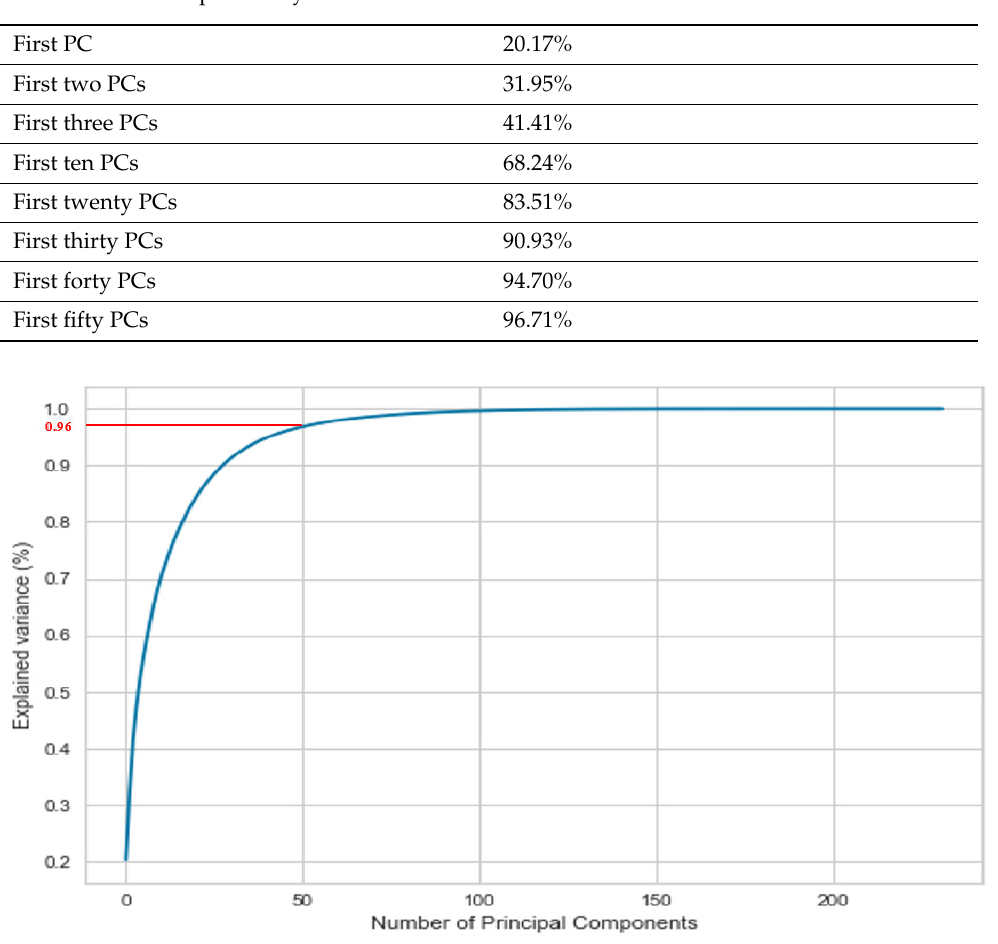
Figure 5. Progression of Explained Variance with